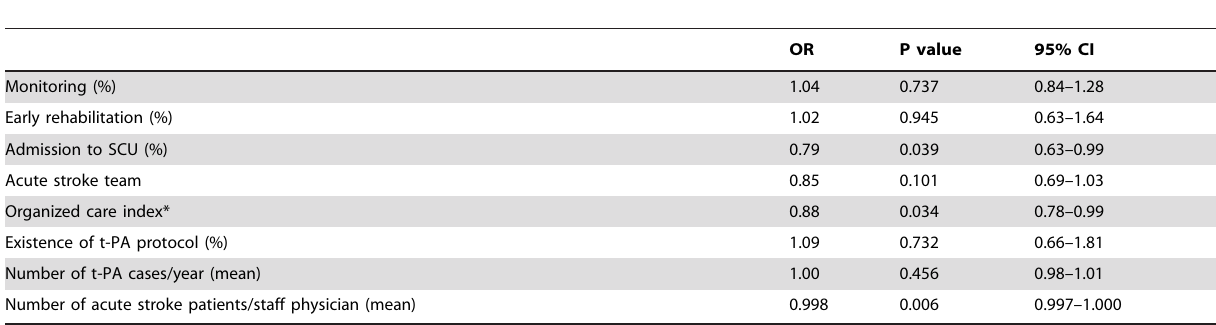
Table 14. Impact of processes of stroke care on in-hospital mortality after subarachnoid